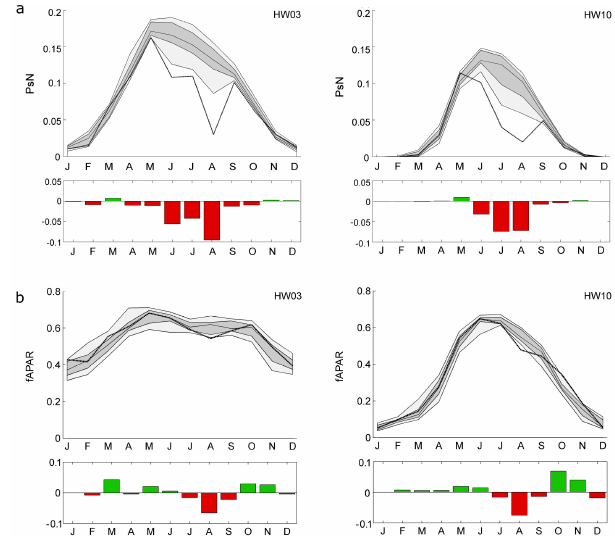
Figure 2. Annual fields of (a) GPP anom (obtained from MOD17A3 algorithm) and (b) Ra anom (computed as the difference between NPP and GPP) for 2003 (left) and 2010 (right) over Europe, please note the use of different scales. The colour map in Ra anom is in- verted so that colours match the net effect on NPP anom in Fig. 1.